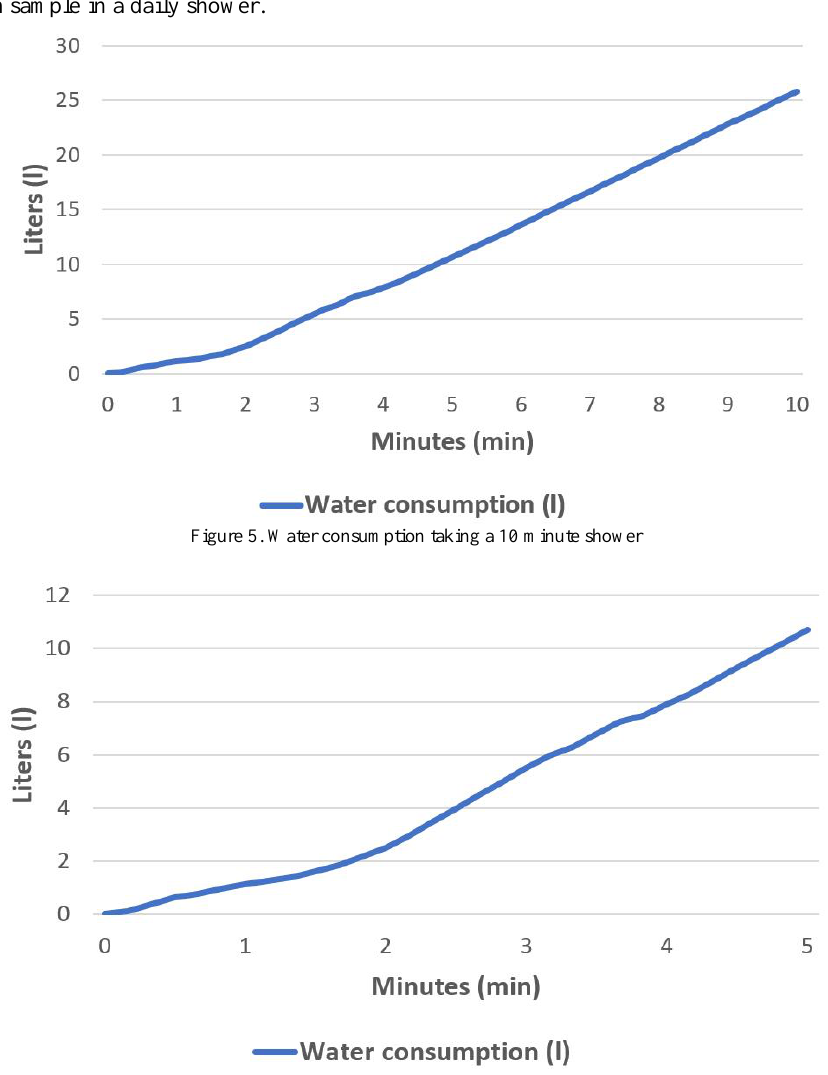
Figure 6. Water consumption taking a 5 minute